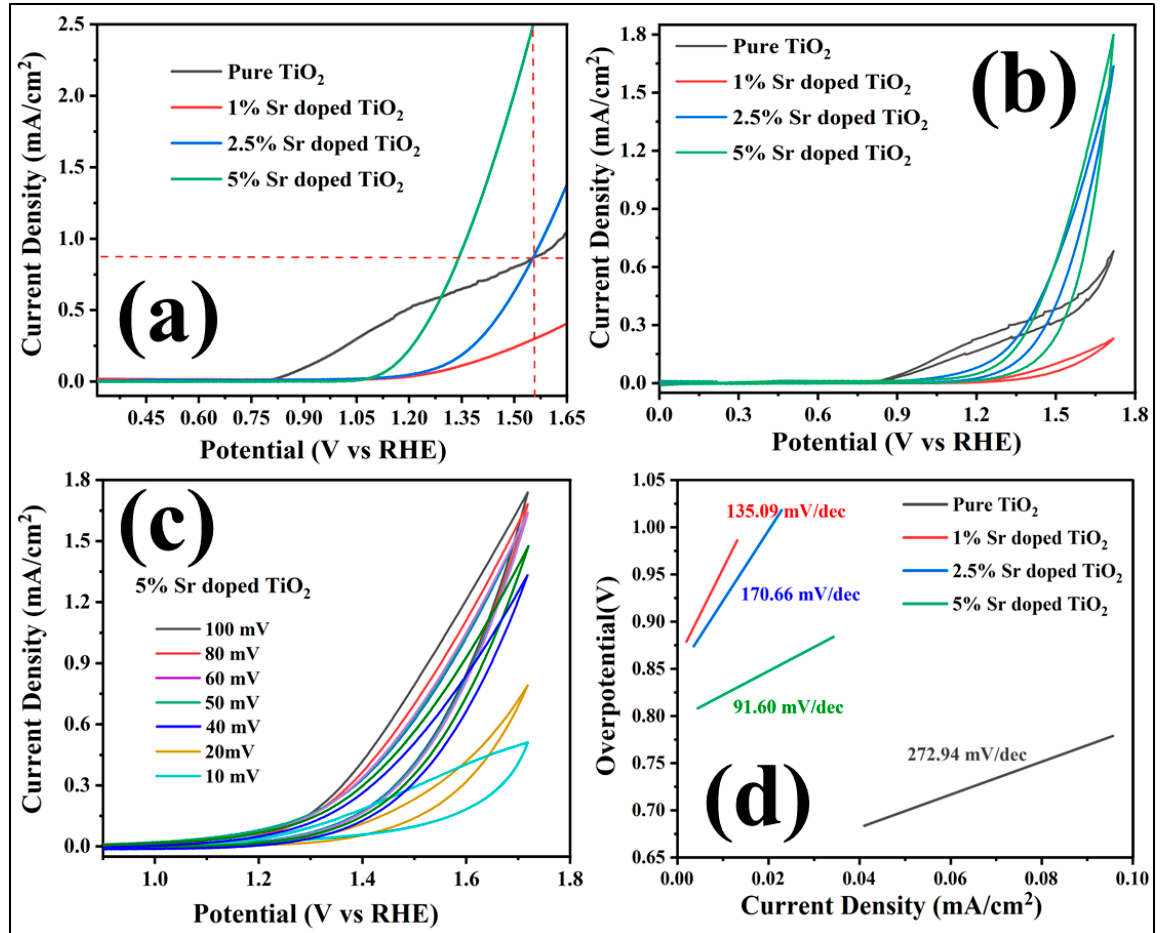
Figure 12. ( a , b ) shows the LSV and CV plots of OER of as-synthesized pristine TiO 2 and 1%, 2.5% and 5% Sr-doped TiO 2 ; ( c ) shows the CV plots of 5% Sr-doped TiO 2 toward OER; ( d ) shows the OER Tafel plots of as-synthesized pristine TiO 2 and 1%, 2.5% and 5% Sr-doped TiO 2 . Table 3. HER and OER electrodic parameters of pristine and Sr-doped TiO 2